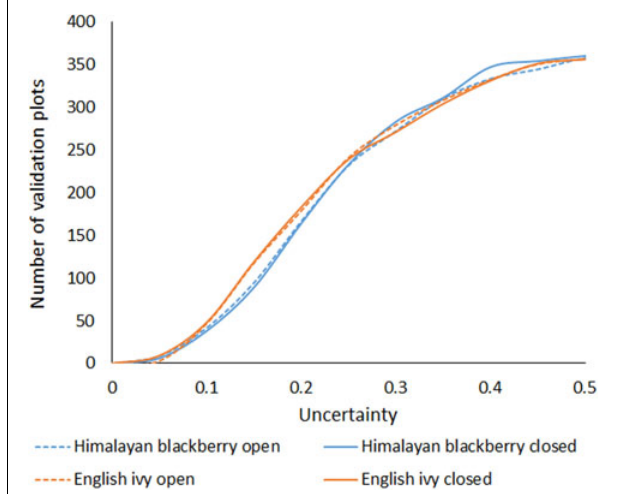
FIGURE 4 | Cumulative sum of uncertainty, calculated by subtracting the random forests probability from 1, for each classification at all of the validation points. Lower values are more